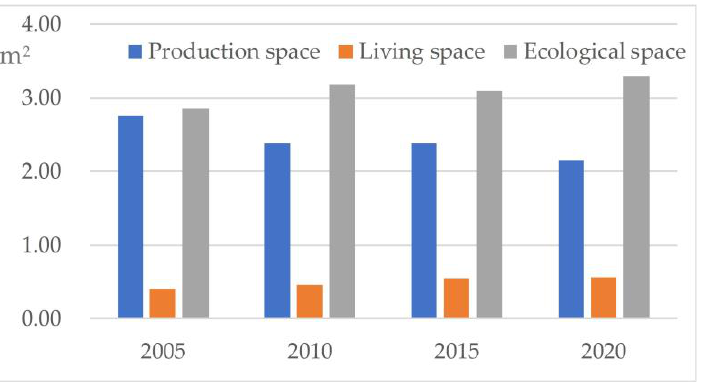
Figure 1. The temporal change in production – living – ecological space in East Tumen Village and West Tumen Village in 2005, 2010, 2015, and